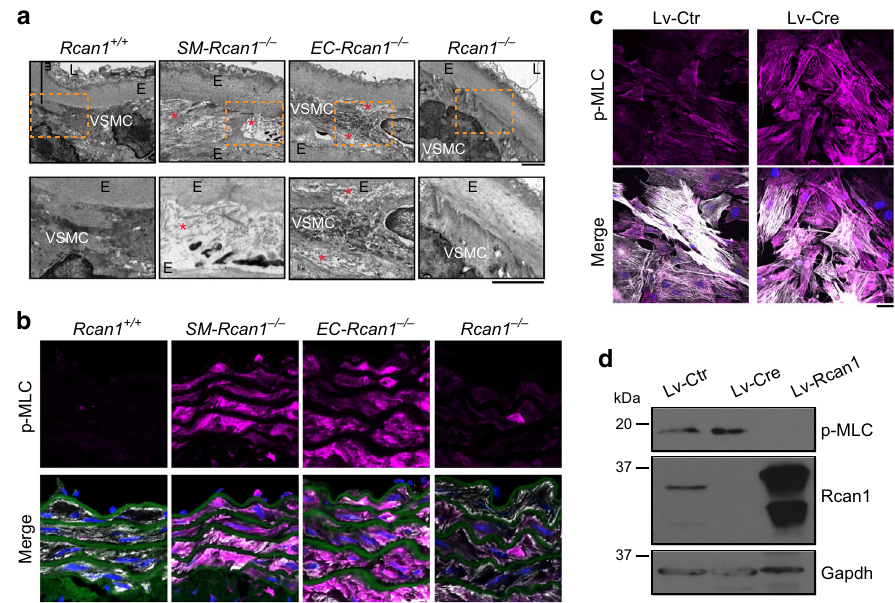
Fig. 6 Vascular ultrastructure alteration and MLC activation in inducible Rcan1 − / − mice. a Representative transmission electron microscopy (TEM) images of aortic sections from Rcan1 + / + ( n = 6), SM-Rcan1 − / − ( n = 6), EC-Rcan1 − / − ( n = 6), and Rcan1 − / − mice ( n = 4). L, lumen; E, elastic lamella; vSMC, vascular smooth muscle cells. Red asterisks mark regions with spaces between elastic layers and vSMCs. Bar, 2 µ m. b Representative images of elastin auto fl uorescence (green), DAPI-stained nuclei (blue), and p-MLC (pink) and SMA (gray) immuno fl uorescence on aortic sections from Rcan1 + / + ( n = 6), SM-Rcan1 − / − ( n = 6), EC-Rcan1 − / − ( n = 6), and Rcan1 − / − mice ( n = 11). Scale bar, 20 µ m. c Representative images of DAPI staining (blue), and p-MLC (pink) and SMA (gray) immuno fl uorescence in Rcan1 fl / fl vSMCs transduced with Cre-encoding or control lentiviral vectors. Scale bar, 20 µ m. d Representative p-MLC, Rcan1, and tubulin immunoblots of Rcan1 fl / fl vSMCs transduced with Cre-encoding or control lentivirus and treated with the ROCK inhibitor Fasudil (30 µ M) for 1 h ( n = 3 independent experiments). a , b Rcan1 + / + littermates consisted of a pool of vehicle-treated Cre-positive